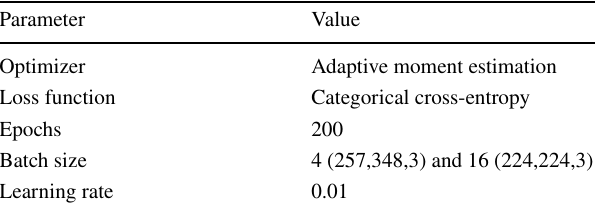
Table 2 The hyperparameters used in our experiments with